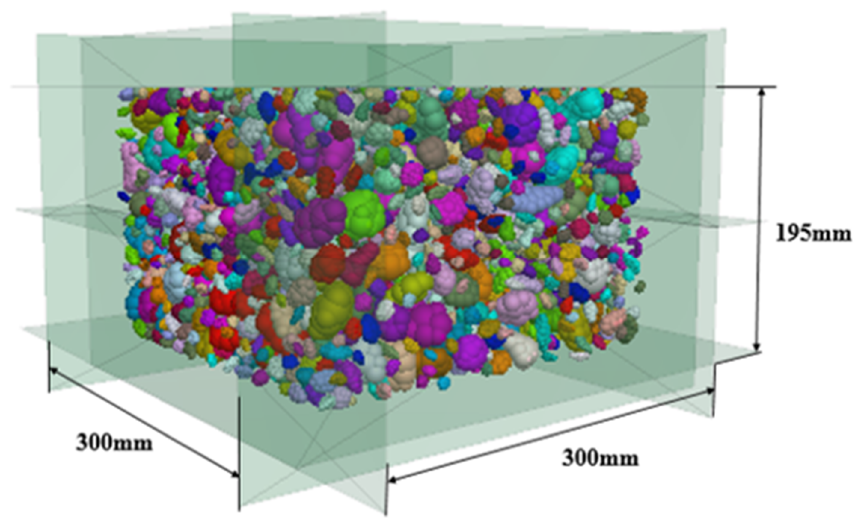
Figure 4. Direct shear box and ballast assembly in PFC 3D .